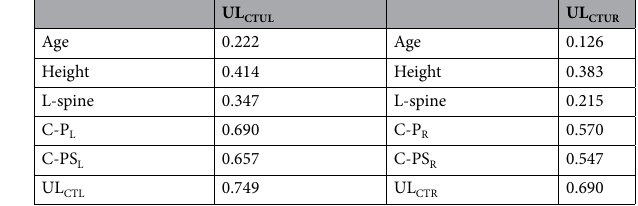
Table 2. The results of Pearson correlation analysis. The subscript L and R is represented with left side and right side, respectively. C-P and C-PS, length measured in KUB radiography. UL CT , length measured in axial CT.